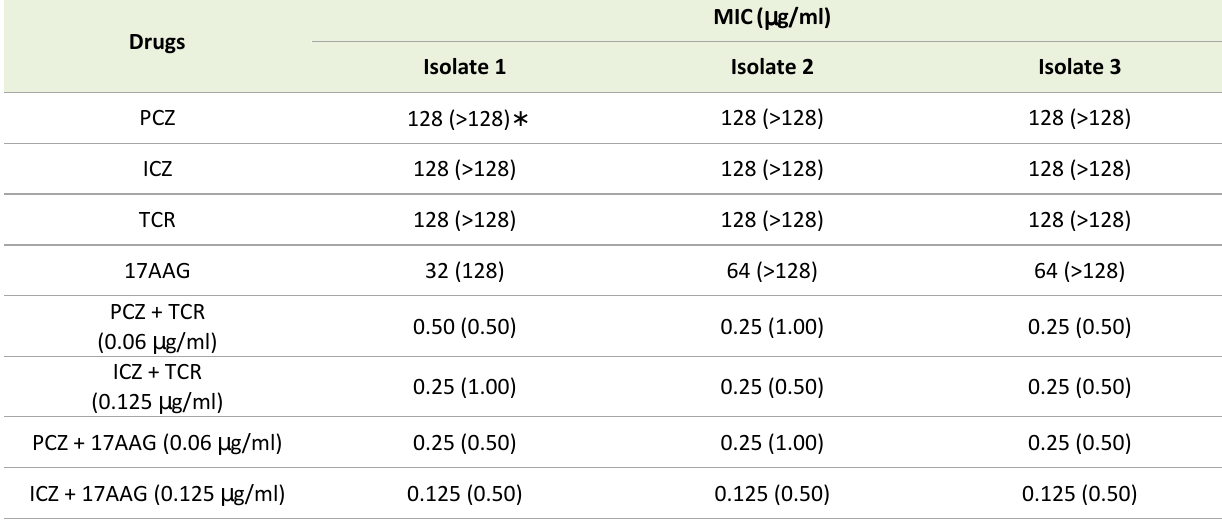
TABLE 1. In vitro antimicrobial activity of PCZ and ICZ in combination with TCR or 17AAG against S. prolificans